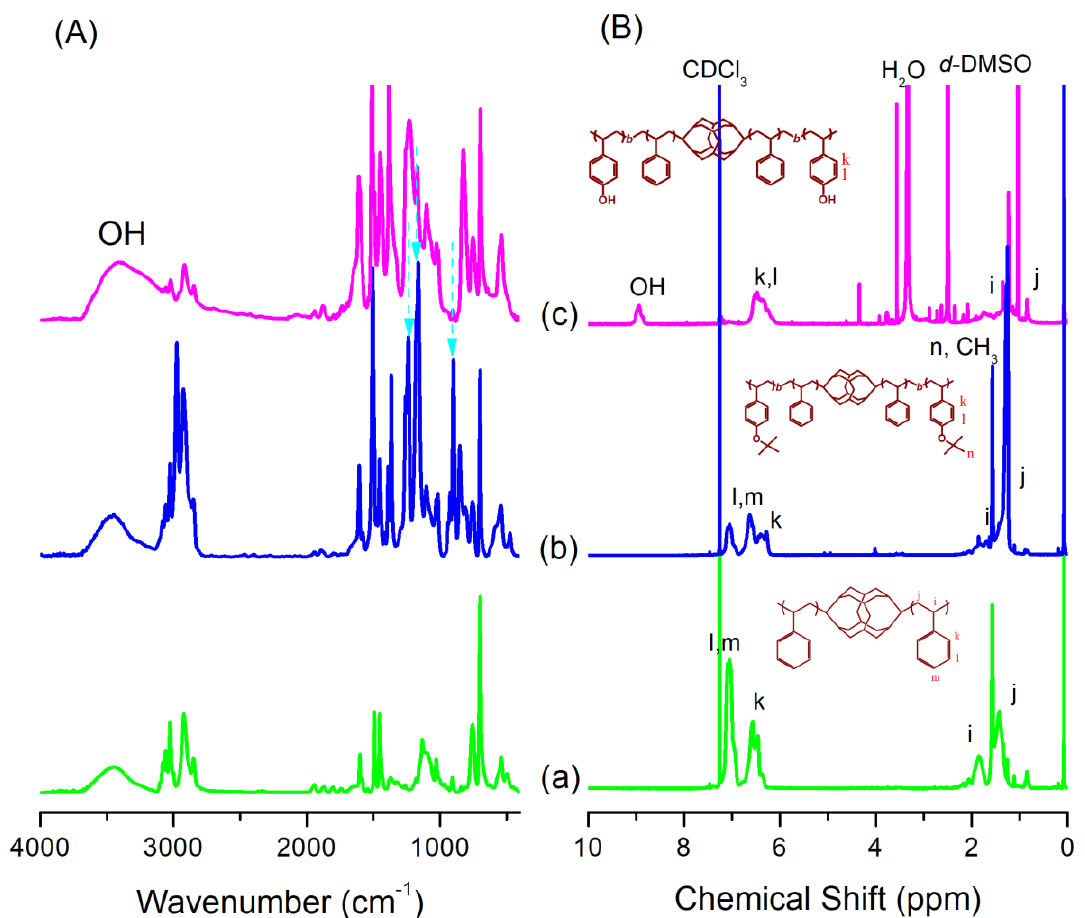
Figure 5. ( A ) FTIR and ( B ) 1 H NMR spectra of ( a ) PS-DDSQ-PS, ( b ) PtBuOS- b -PS-DDSQ-PS- b -PtBuOS, and ( c ) PVPh- b -PS-DDSQ-PS- b -PVPh.